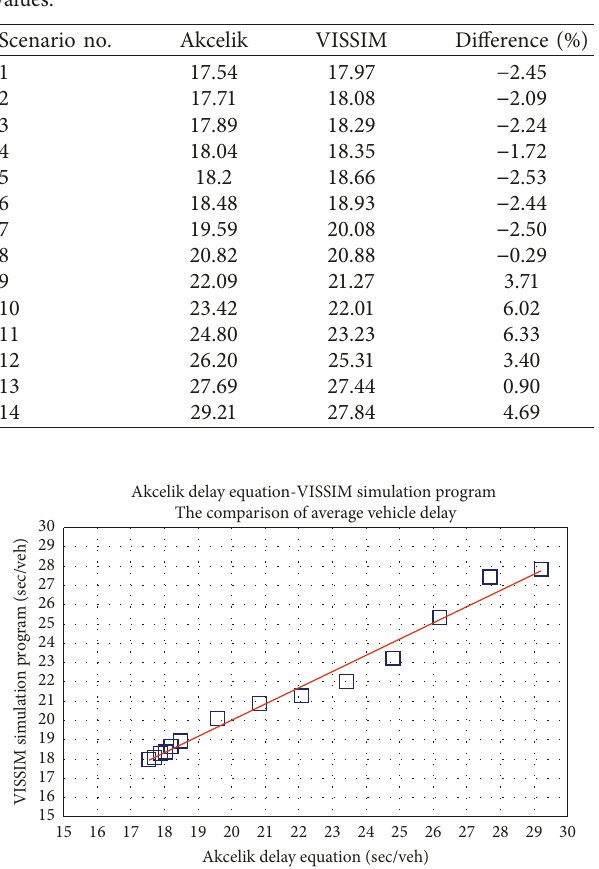
Figure 8: Comparison of average vehicle delays which were ob- tained from VISSIM and Akcelik average delay equation.